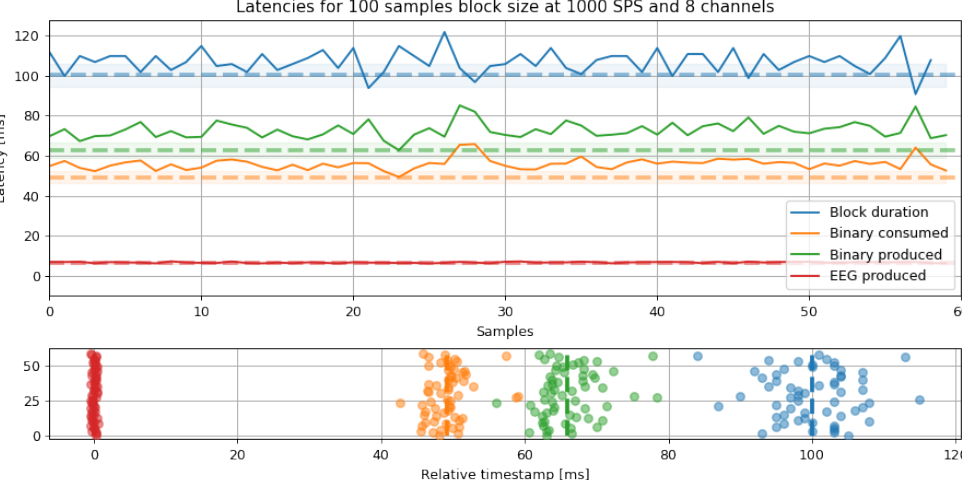
Figure 10. Latency analysis for a fixed 100 samples block size and 1000 SPS. The latencies show the elapsed time from reading the packet to the packaging time. The dashed line marks the minimum latency, and the shade is the standard deviation for all segments.